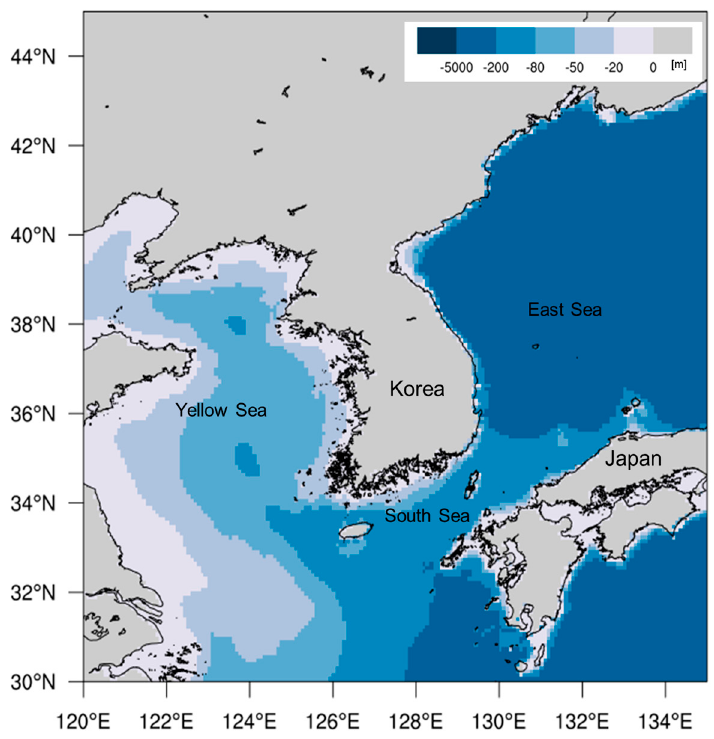
Figure 1. Bathymetry of the study area.